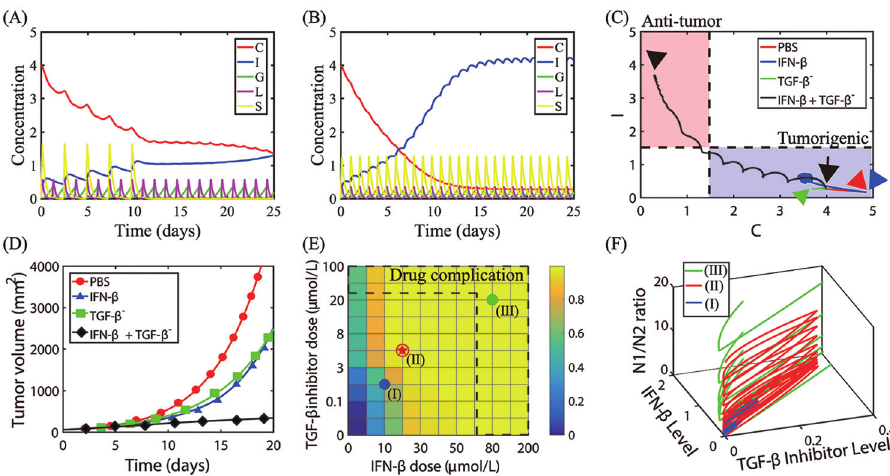
Fig 16. Therapeutic effect of a combination therapy (TGF- β inhibitor + IFN- β ) on tumor growth. (A) Time courses of the N2 ( C ) and N1 complex ( I ) activity, and concentrations of TGF- β ( G ), TGF- β inhibitor ( L ), and IFN- β ( S ) in response to a periodic injection of TGF- β inhibitor every day ( τ L = 1 day ) and IFN- β on 0, 3, 5, 7, 9 days. L s = 8, S s = 20. (B) Time courses of all variables ( C , I , G , L , S ) in response to a periodic injection of both TGF- β inhibitor and IFN- β every day. L s = 5, S s = 15. (C) Trajectories of solutions ( C ( t ), I ( t )) in response to control (PBS, red) and injections of IFN- β only (blue), TGF- β inhibitor only (TGF- β − , green), and combination therapy (IFN- β + TGF- β inhibitor, black). Black arrow = initial position, arrowheads = terminal points at t = 25 day for four cases. L Time courses of tumor volume corresponding to four cases in (C). The combination therapy leads to synergistic effect